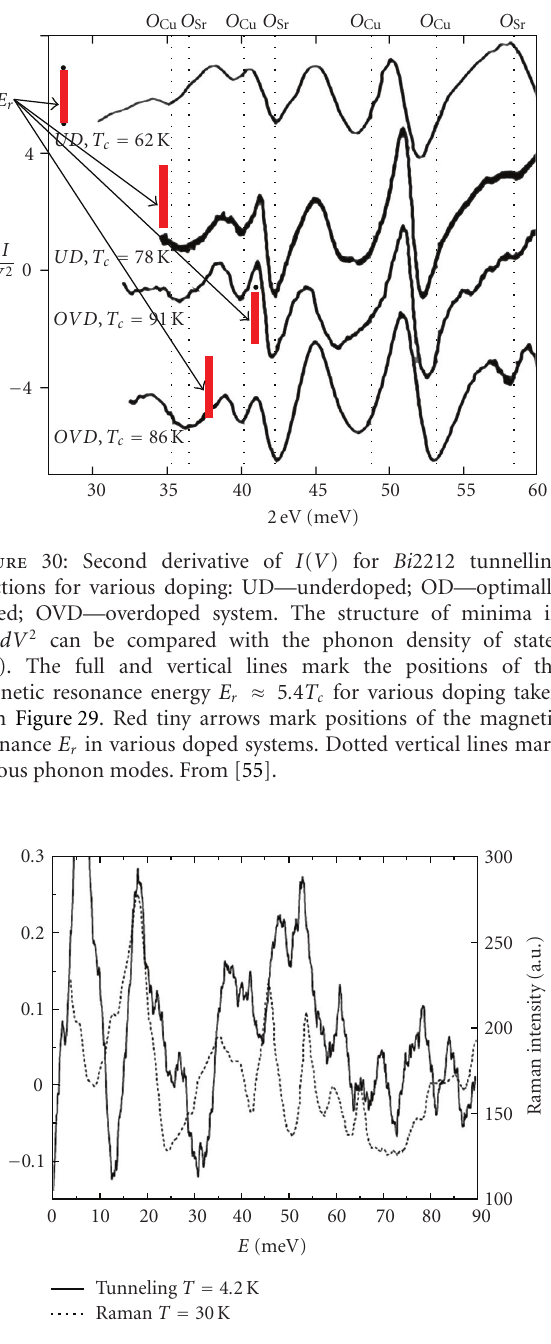
Figure 31: Second derivative data d 2 I ( V ) /dV 2 of the tunnelling spectra on thin films of La 1 . 85 Sr 0 . 15 CuO 4 are shown along with phonon Raman scattering data on single crystals of LSCO with 20% Sr. The polarization of the incident and scattered light in the Raman spectra is parallel to the CuO 2 planes. From